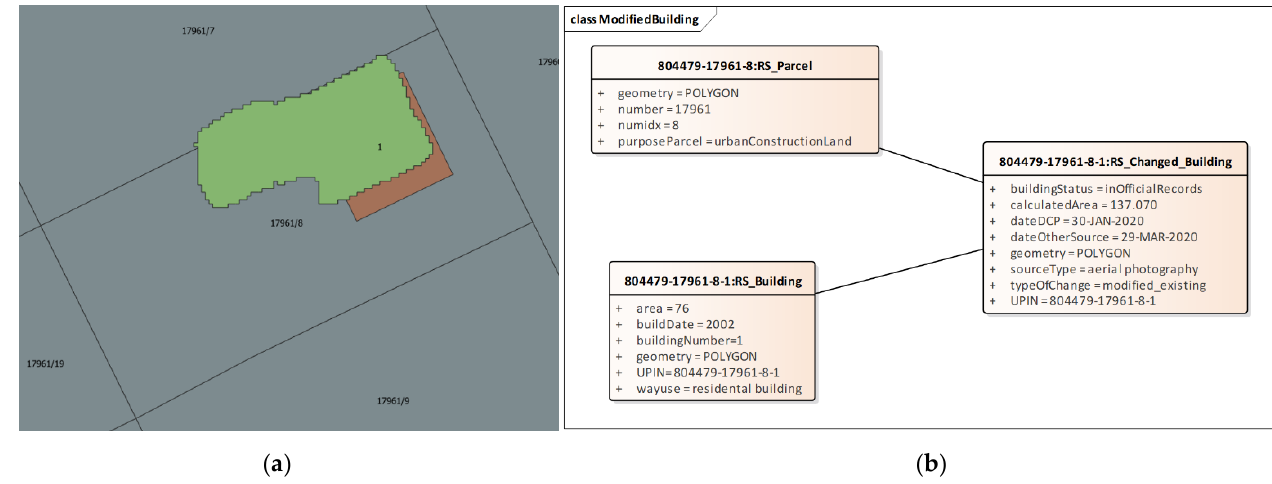
Remote Sens. 2021 , 13 , x FOR PEER REVIEW Figure 29. ( a ) Purple—parcels in the official records, yellow—buildings in the official records, pink—detected buildings. ( b ) An instance diagram of detected new buildings.